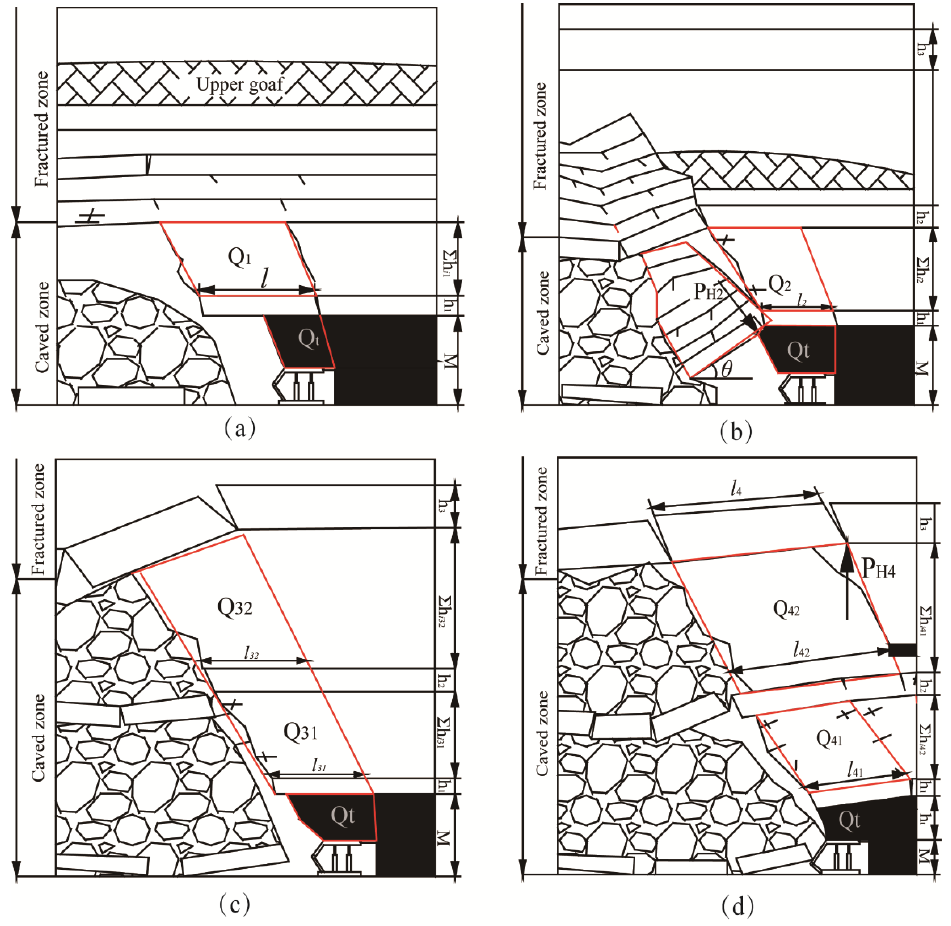
Figure 11. Support resistance calculation models.